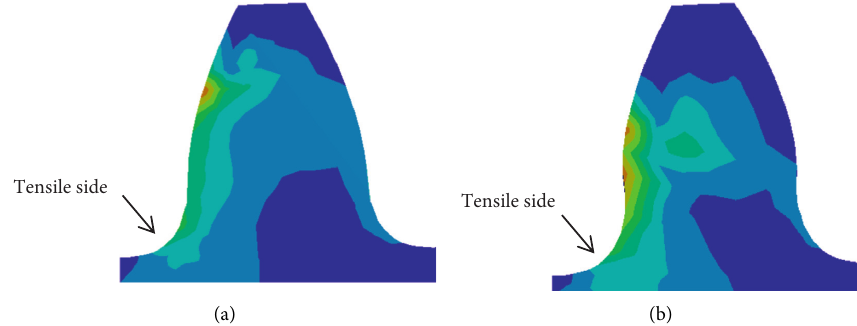
Figure 17: Root stress of the planetary gear train. (a) Root stress cloud of the sun gear. (b) Root stress cloud of the planetary